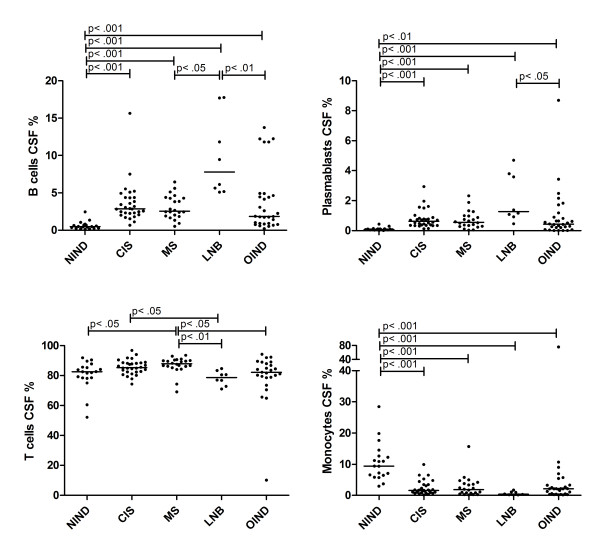
 Immune cell subsets in CSF. The percentage of B cells, plasmablasts, T cells and monocytes in the CSF of patients with NIND, CIS, MS, LNB and OIND are shown. Values are given as the proportion of flow cell count in the CSF, the horizontal line indicates median. Significant P-values for the comparison among groups are displayed.